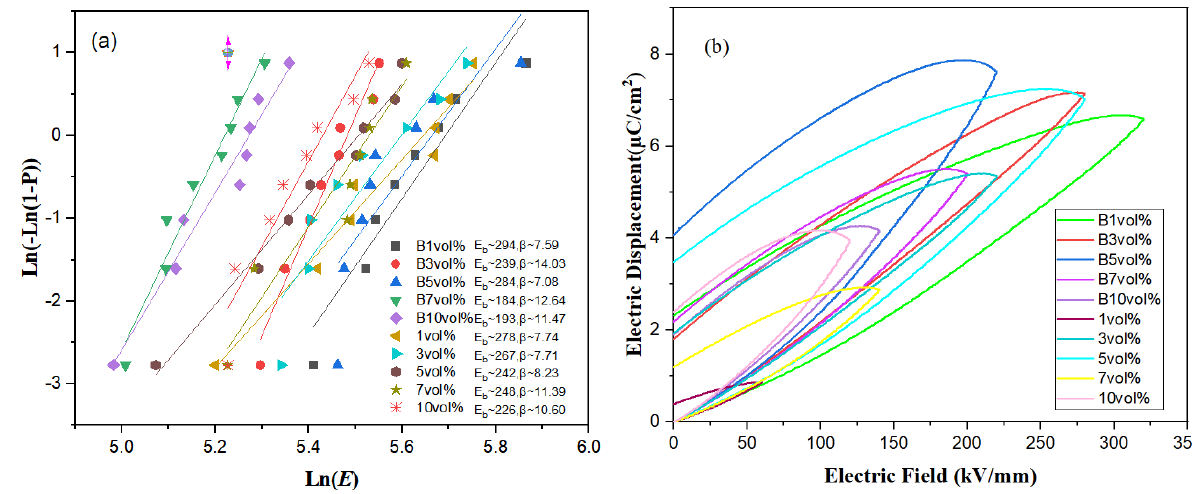
Figure 8. Breakdown strength ( a ) and D-E curves ( b ) for 7FO/PVDF nanocomposite films with different doping